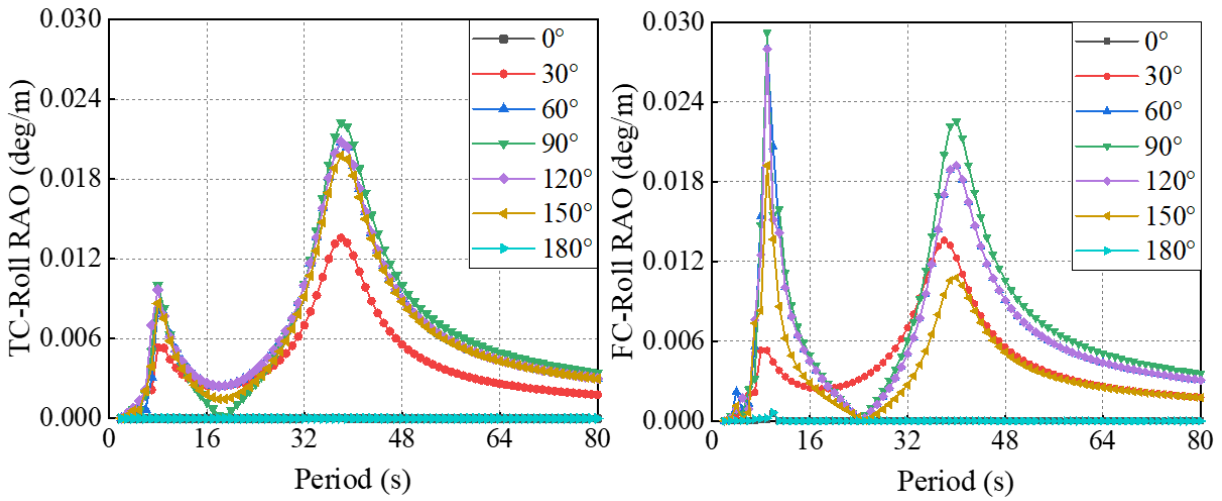
Figure 9. Roll motion RAOs of SFOWTs.